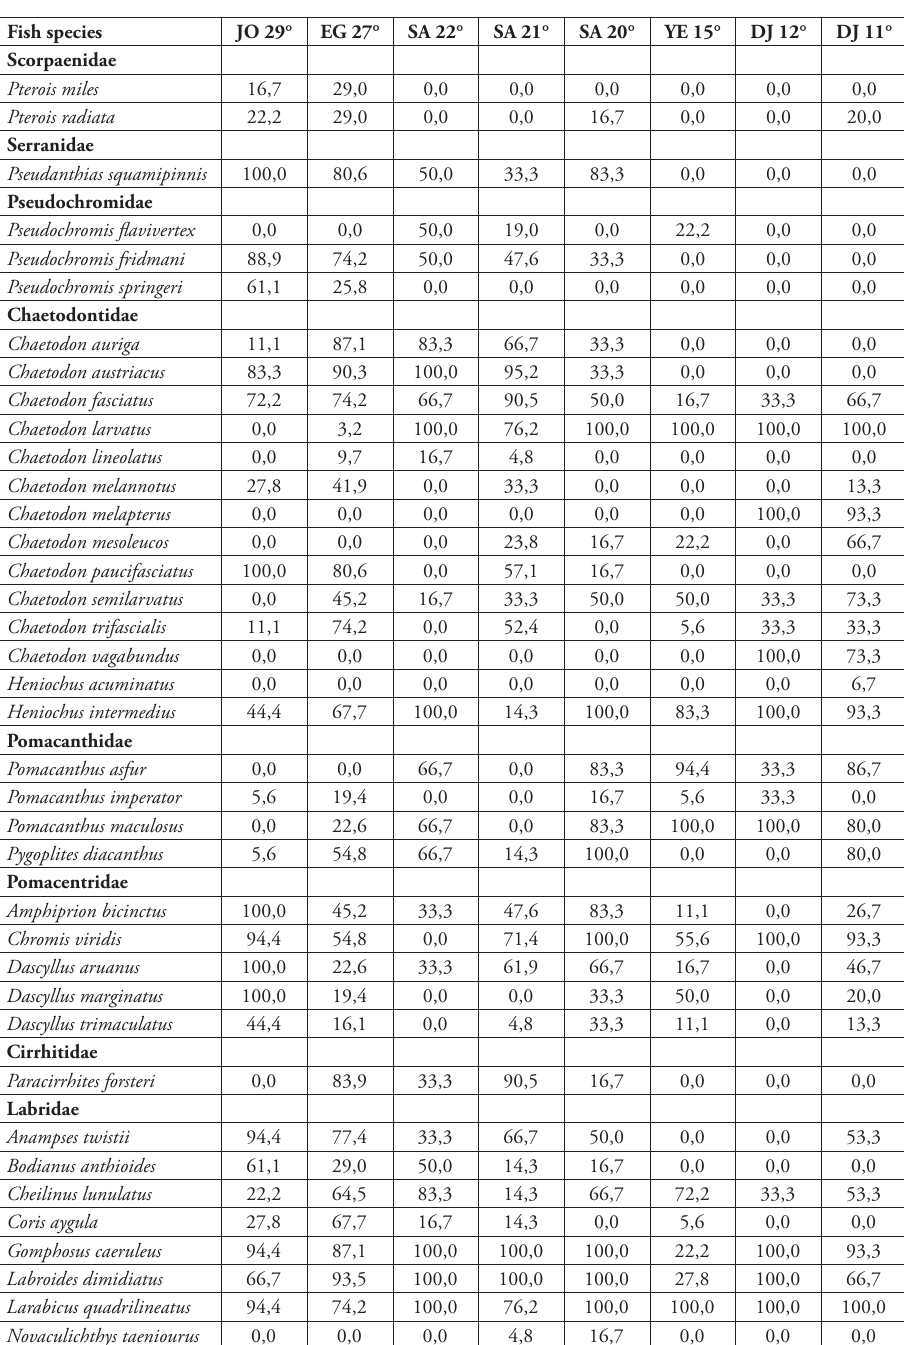
table 3. Frequency of appearance in % of fish individuals per 500m² transect along reefs at JO= Jor- dan latitude 29°; EG=Egypt latitude 27°; SA=Saudi Arabia latitude 22, 21, 20°; YE=Yemen 15° and DJ=Djibouti latitude 12,